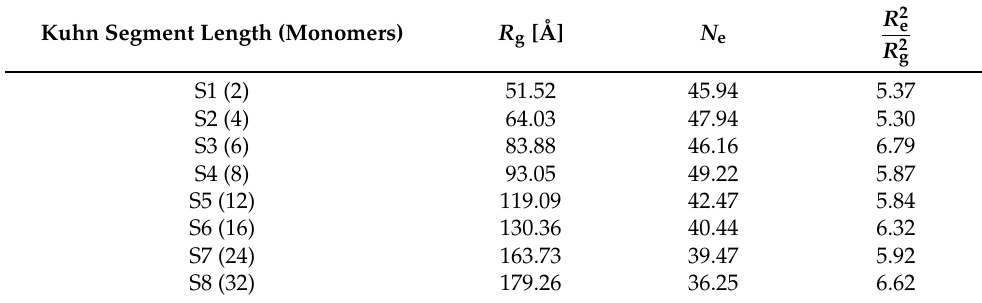
Table 1. Properties of simulation cells of M n = 32.8 kg/mol with different spatial distributions. Kuhn Segment Length (Monomers)